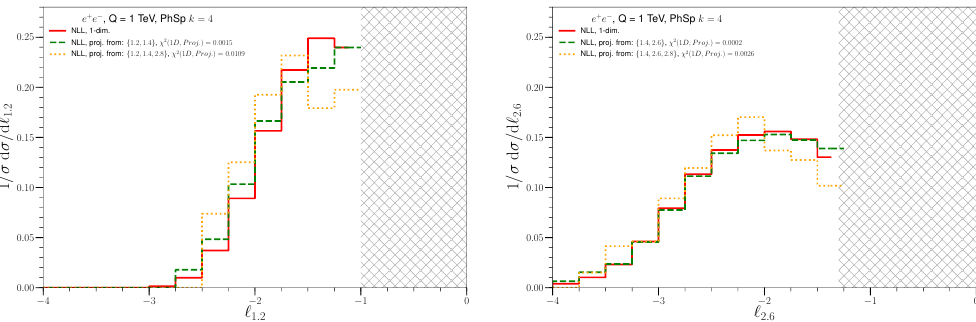
Figure 12 . The projections from multi-di(cid:11)erential angularity distributions down to the distribution for a single angularity for two speci(cid:12)c choices (cid:11) j = 1 : 2 (left panel) and 2.6 (right panel). The (cid:31) 2 gives the di(cid:11)erence between the one-dimensional resummed angularity distribution and each of these